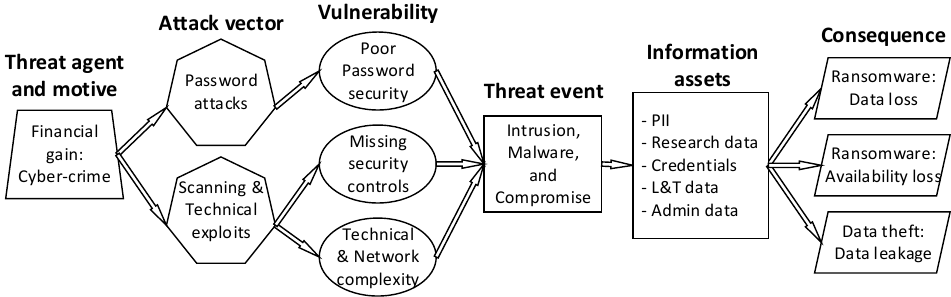
Figure 3. Risk analysis combining threat agents, vulnerabilities, events, assets, and consequences, for the “Intrusions, malware, and compromise”-events. Table 15. Categorized and merged threat events from the findings in [6,9,53,61–66], n =